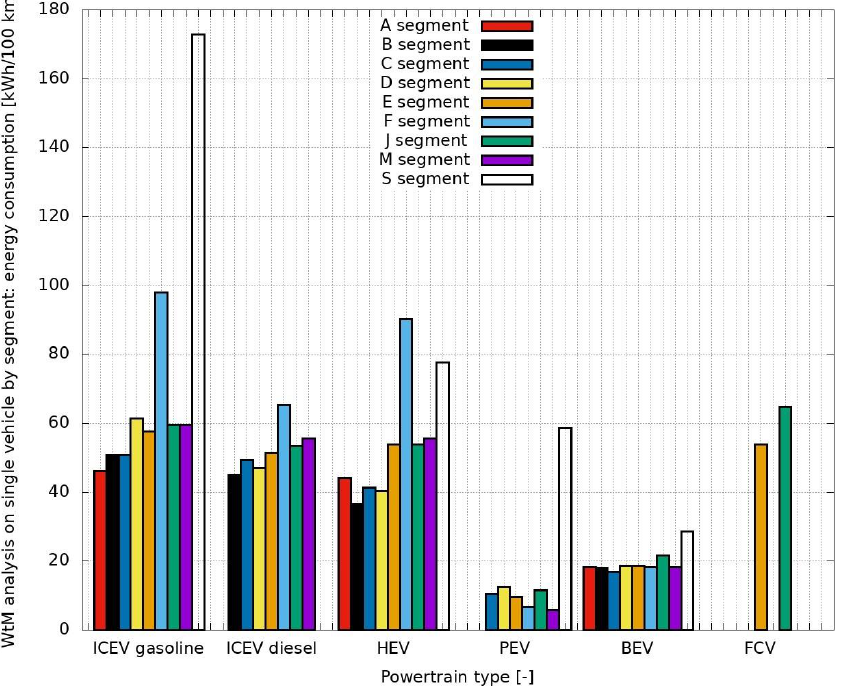
Figure 11. WtM analysis on single vehicle per powertrain type and H1 segment — Mean consumption based on WLTP cycle [15,20] — The zero value stands for no data available.